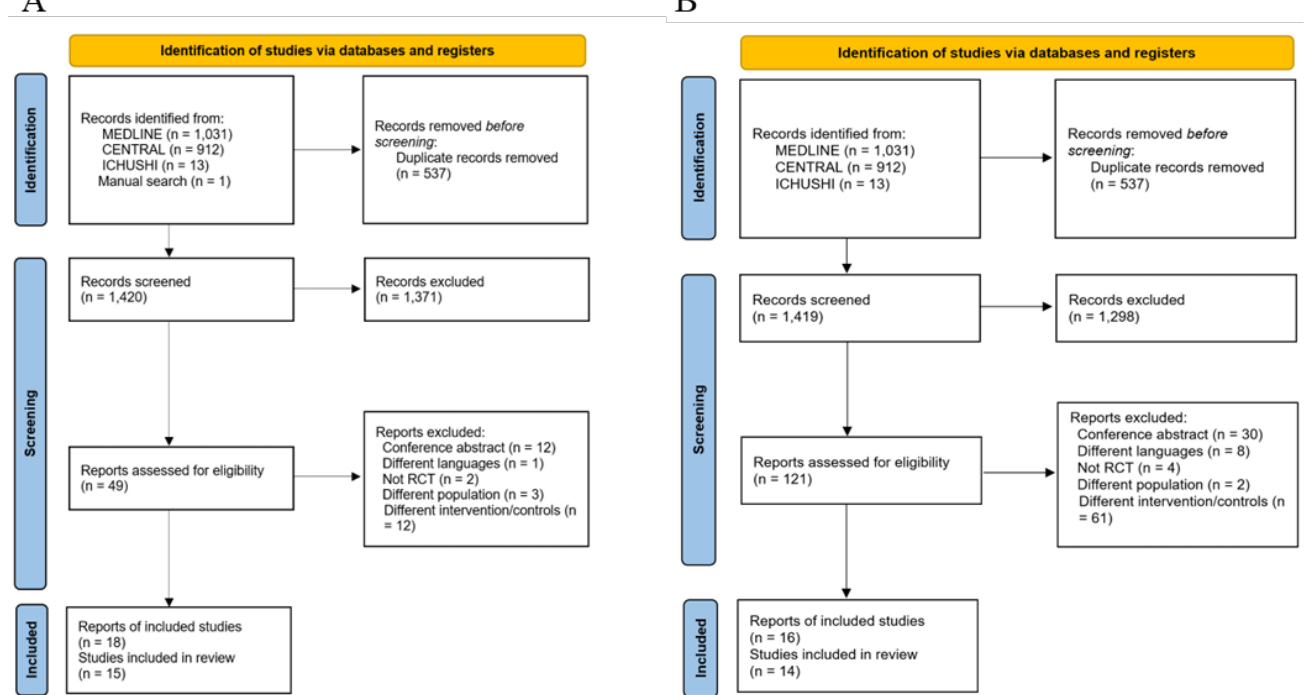
Figure 1. Flow chart of the study included in this systematic review. ( A ) Energy delivery. ( B ) Protein delivery.